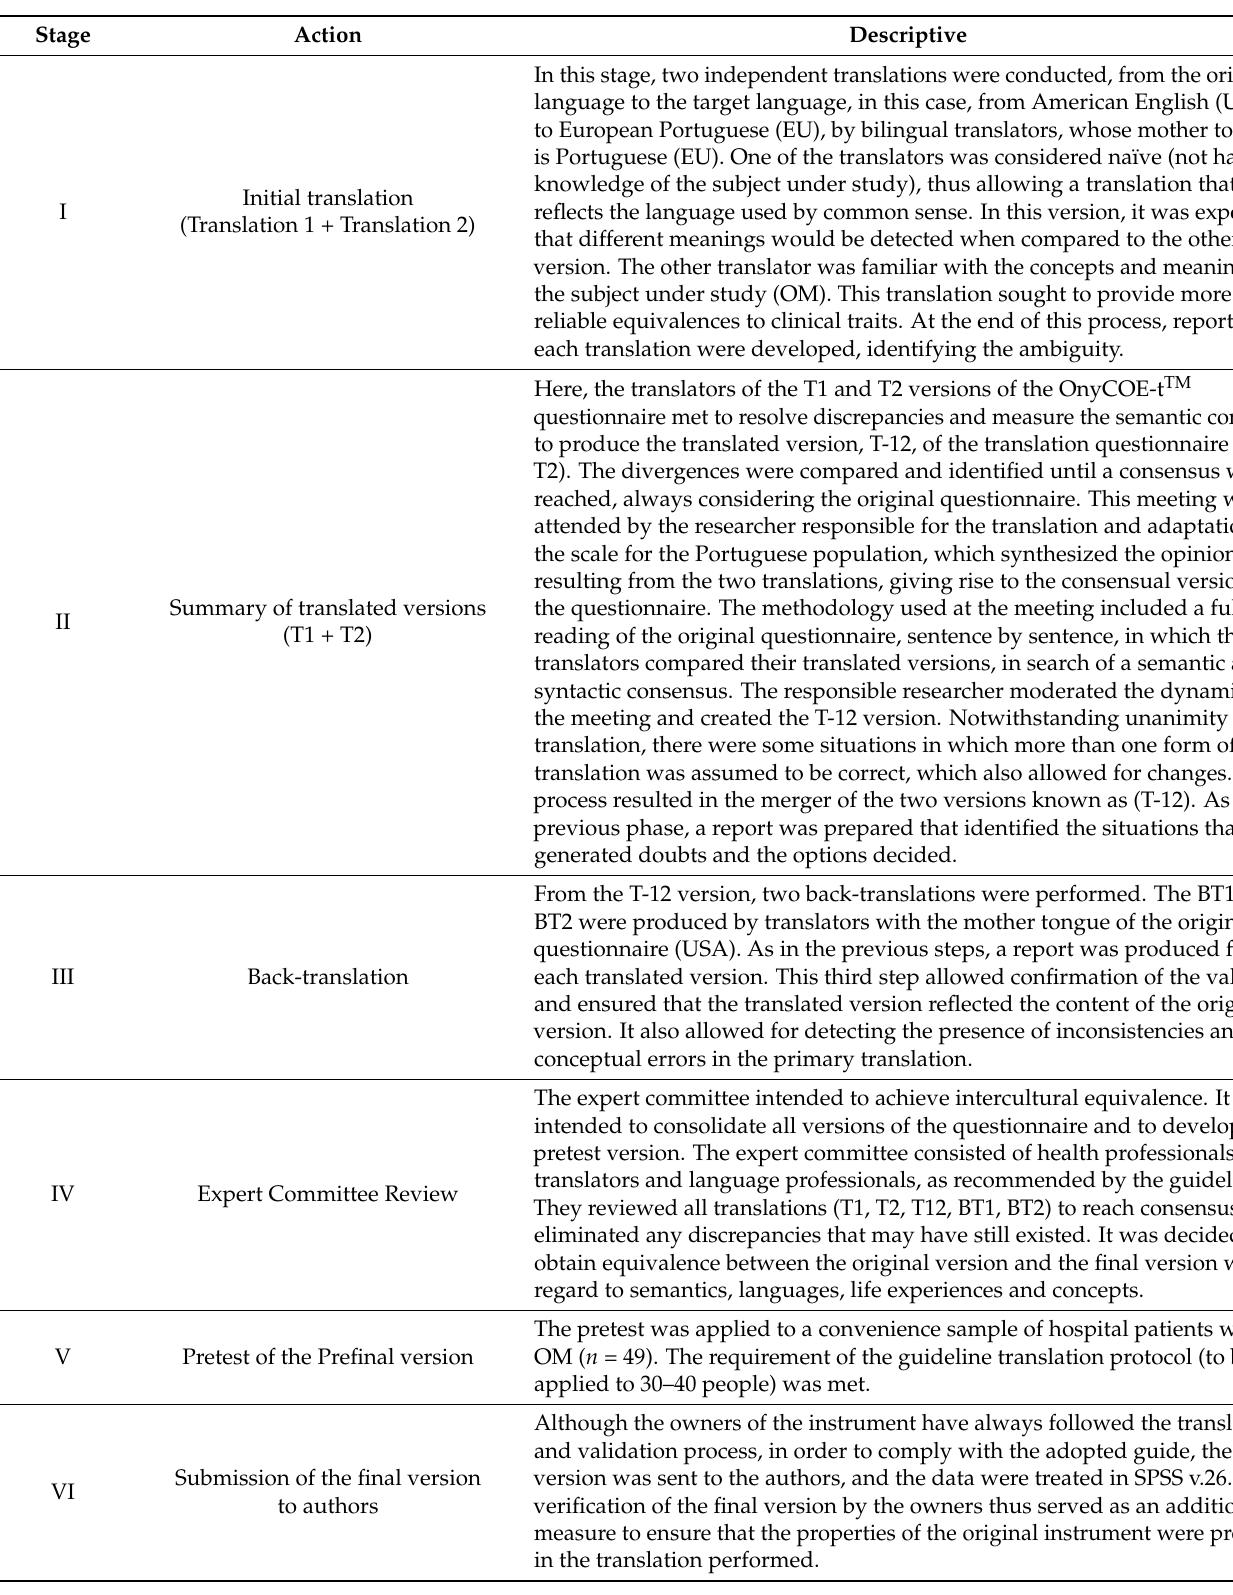
Table 1. Description of the translation process adapted from Beaton et al.